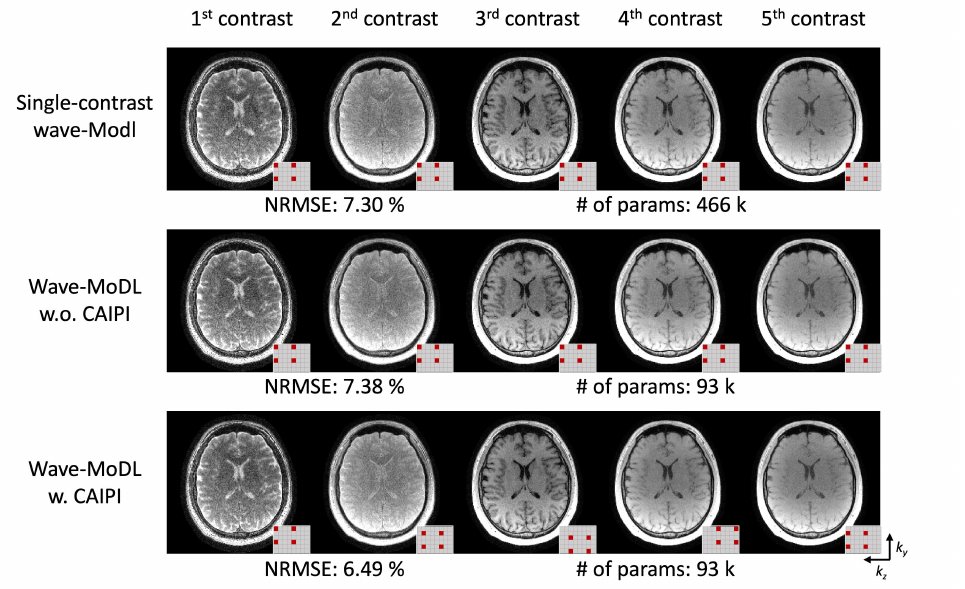
Figure 7. ( top ) Five individual single-contrast wave-MoDL reconstructions for each contrast and ( middle , bottom ) joint-wave-MoDL with and without CAIPI sampling pattern across contrasts. The small pattern in the right bottom corner of each image shows the sampling in the k y and k z